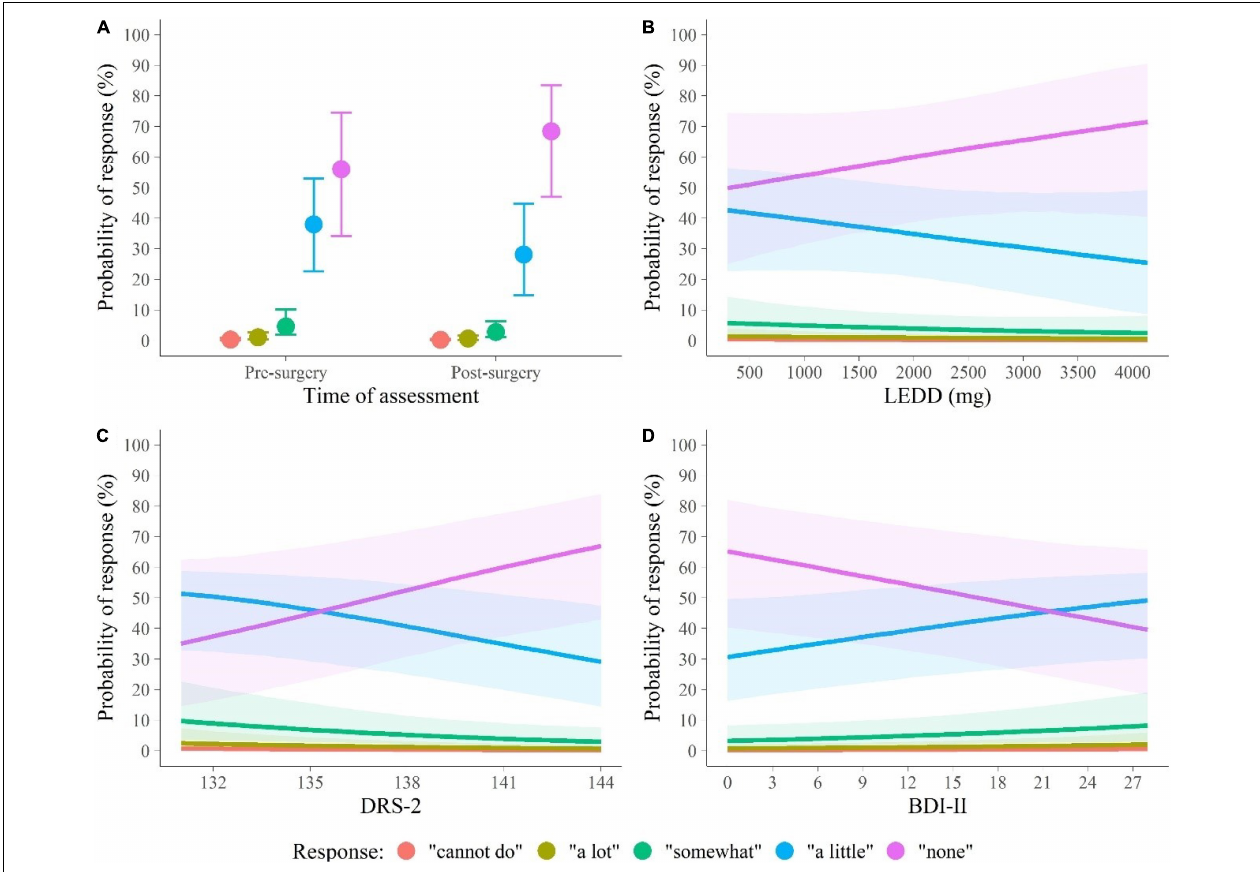
FIGURE 2 | Summary of the marginal distributions of main effects of (A) the time of assessment, (B) LEDD, (C) DRS-2, and (D) BDI-II on IADL. BDI-II, Beck Depression Inventory; DRS-2, Dementia Rating Scale, second edition; IADL, instrumental activities of daily living; LEDD, levodopa equivalent daily dose. Points (lines) represent the median probability of each response (labeled by distinct colors) to the items of Penn Parkinson’s Daily Activities Questionnaire-15 (PDAQ-15), and whiskers (shades) represent 95% posterior probability intervals (PPIs).